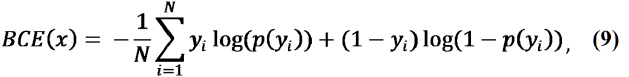
Table 4. Cross-validation accuracy comparison.